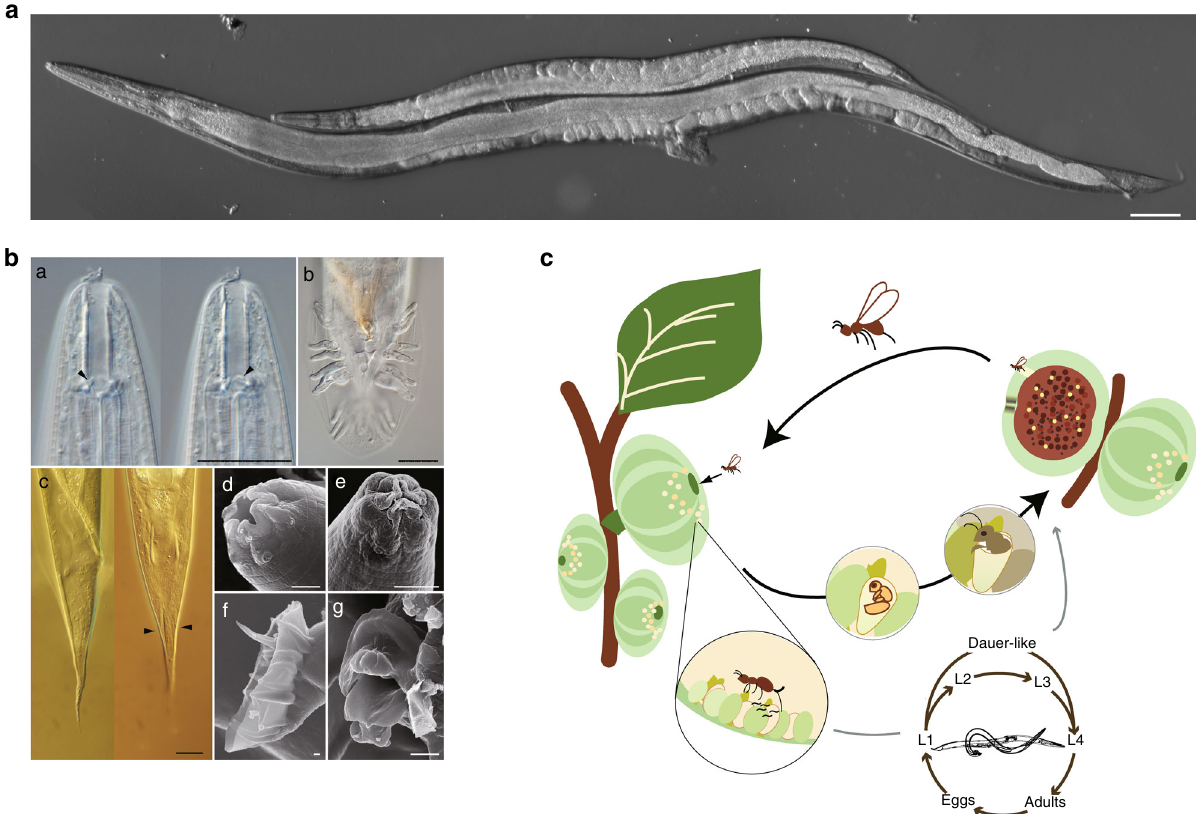
Fig. 1 C. inopinata biology compared with the sibling species C. elegans . a DIC microscopic views of C. inopinata (adult female; bottom) with C. elegans (hermaphrodite; top). Scale bar: 100 μ m. b Key morphological characters of C. inopinata . a: right lateral view of stomatal part in different focal planes showing dorsal tooth (left) and right subventral tooth (right) with arrow heads. b: ventral view of male tail. c: female tail in right lateral (left) and ventral (right) view showing phasmids in arrowheads. d: face view of stomatal part of adult. e: face view of stomatal part of dauer-like juvenile. f: left lateral view of male tail. g : ventral view of male cloacal opening. Scale bars: 20 μ m for a – c, 2 μ m for d – g. c Life cycle of C. inopinata . The nematodes multiply in fresh syconia of Ficus septica , which has a mutualistic association with the pollinating wasp Ceratosolen sp. When the syconia mature nematodes in the dauer form disperse to new young syconia using the wasps as a